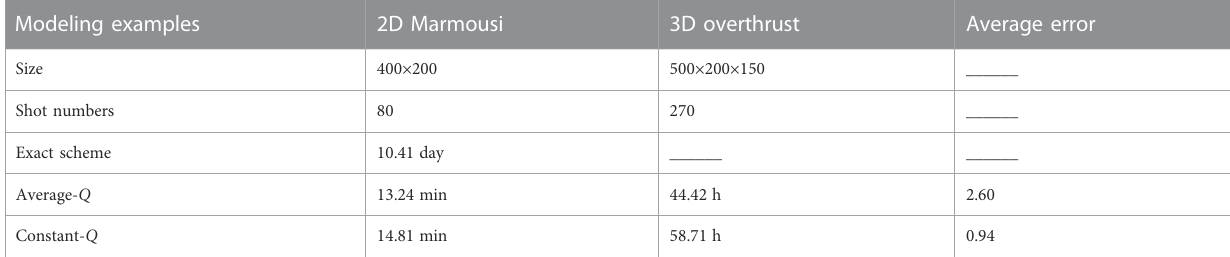
demonstrating the effectiveness of the proposed method in the 3D case.